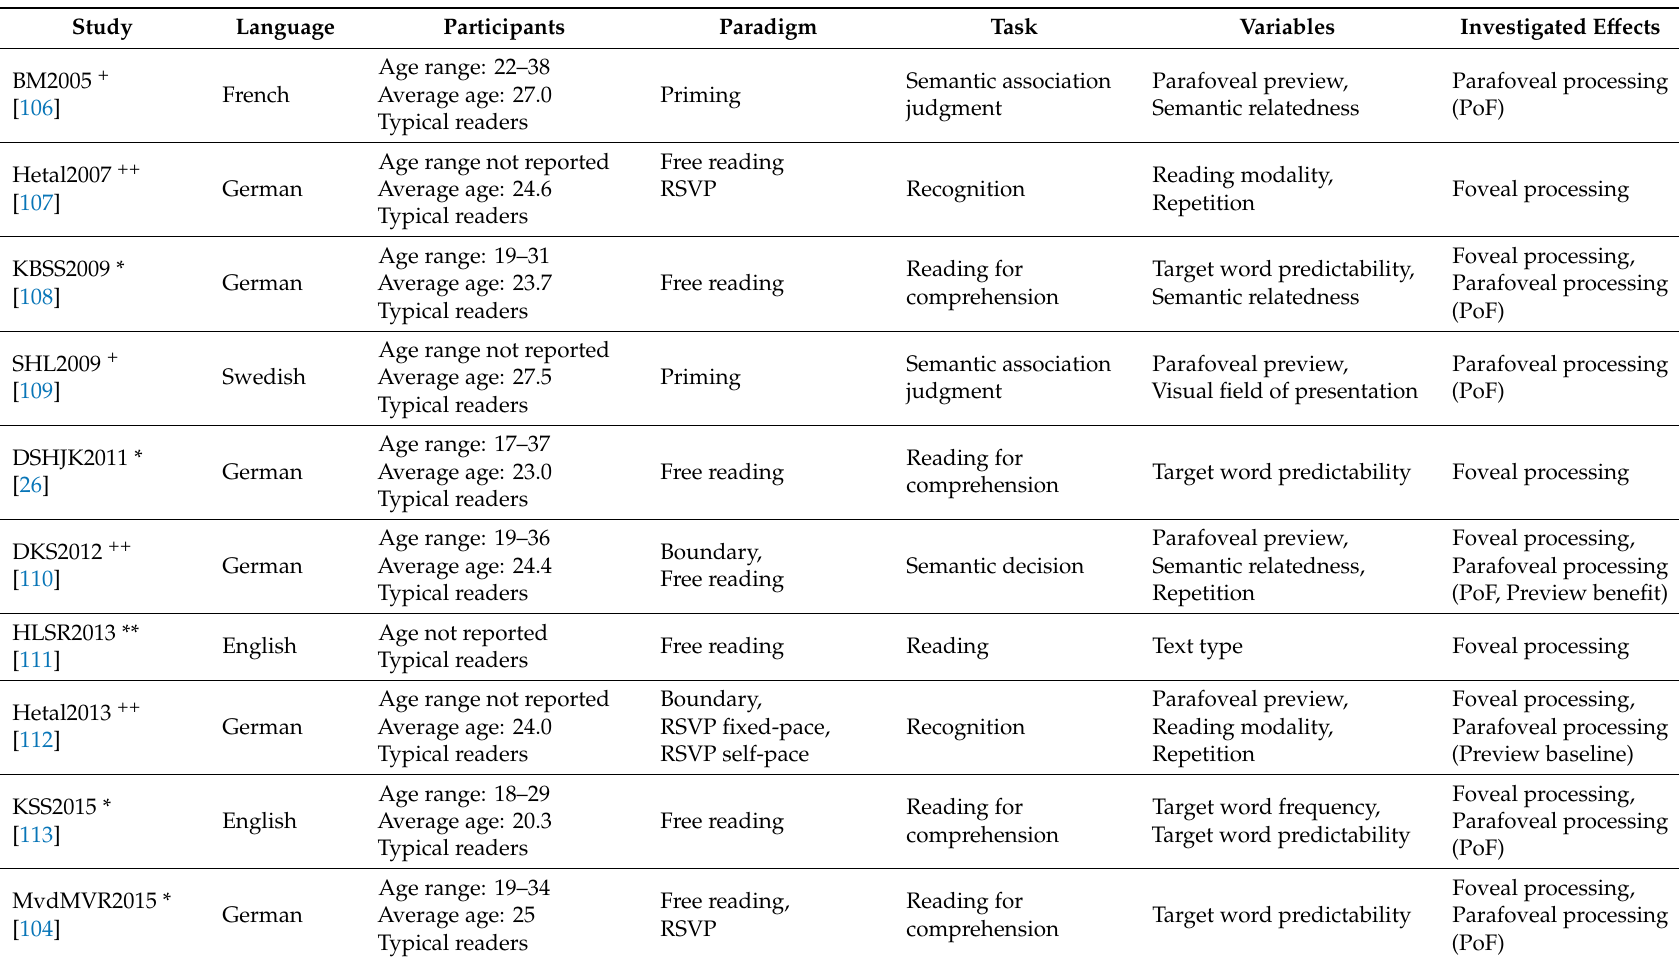
Table 1. Co-Registration Studies Presenting Pairs of Words ( + ), Lists of Words ( ++ ), Sentences (*) or Paragraphs